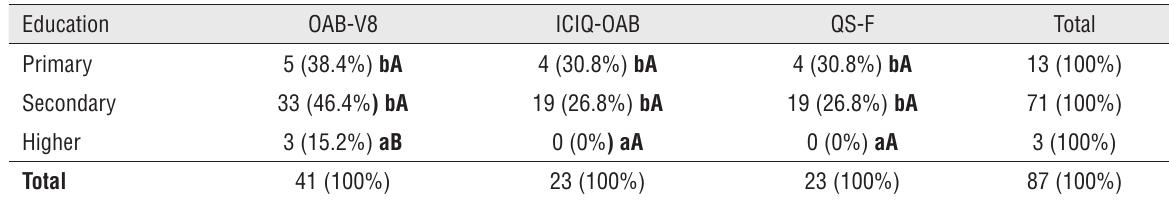
Table 4 - number and percentage of women who needed assistance to answer the questionnaires according to the level of education.